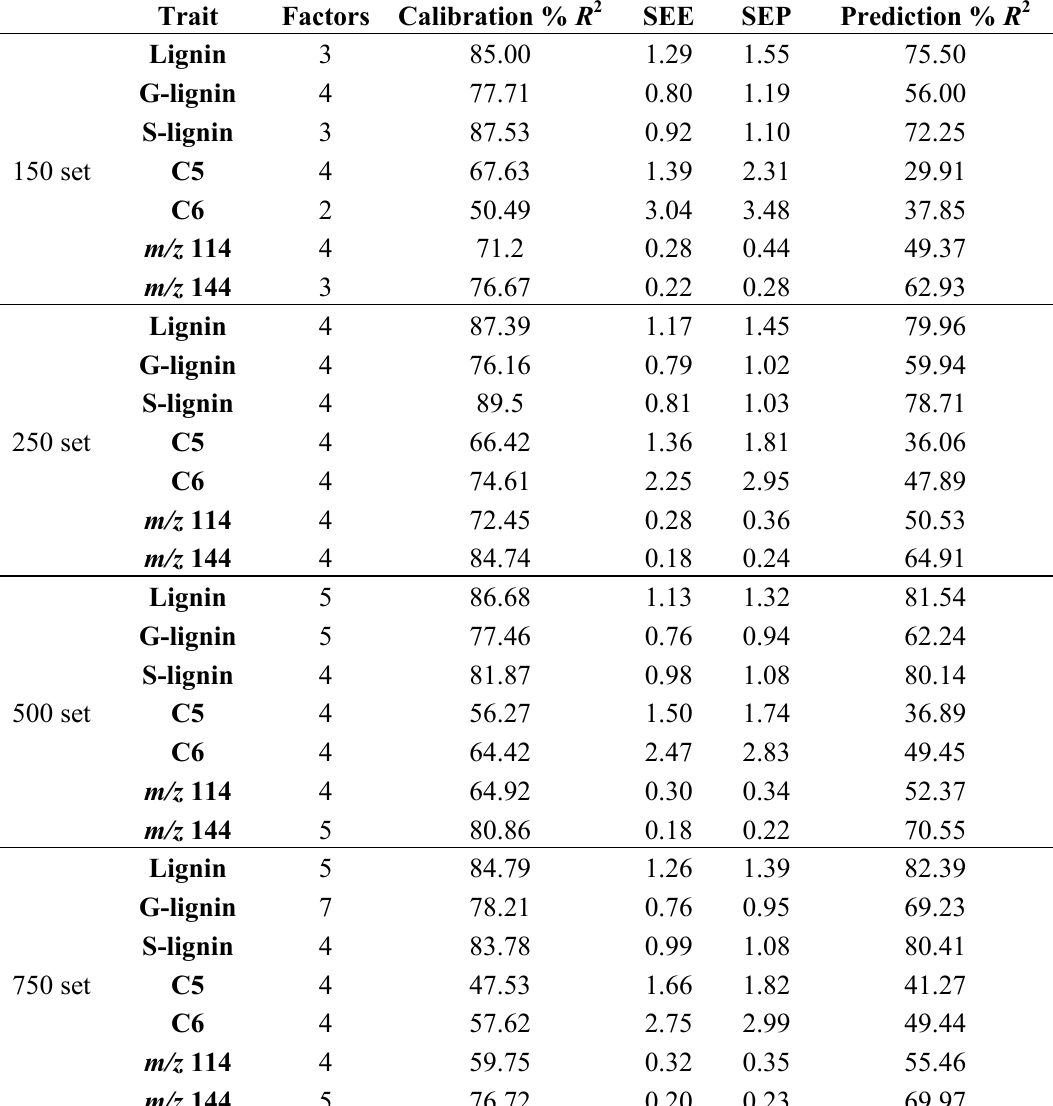
Table 1. Different sample size calibration and prediction